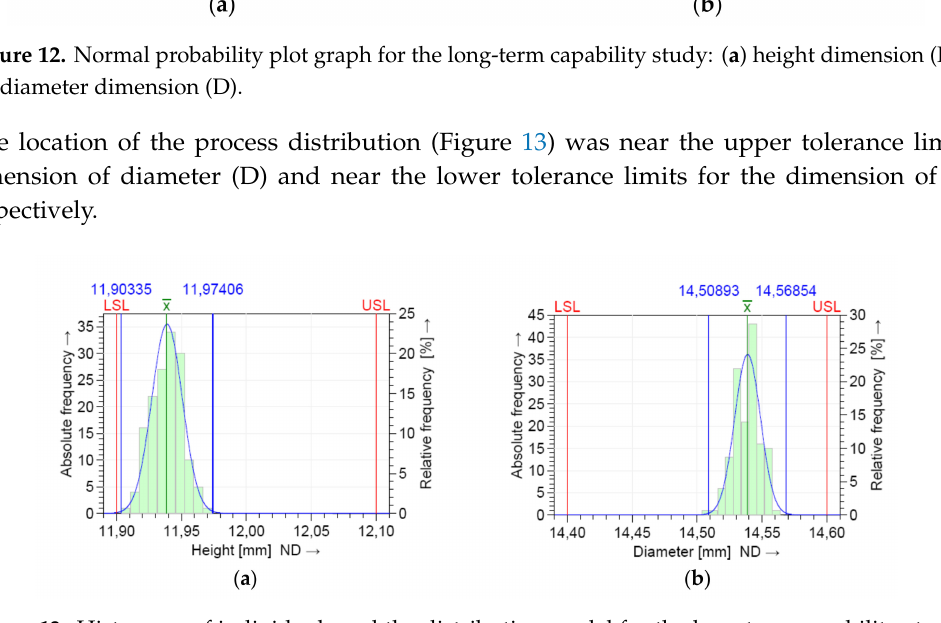
Figure 13. Histogram of individuals and the distribution model for the long-term capability study: ( a ) height dimension (H); ( b ) diameter dimension (D).